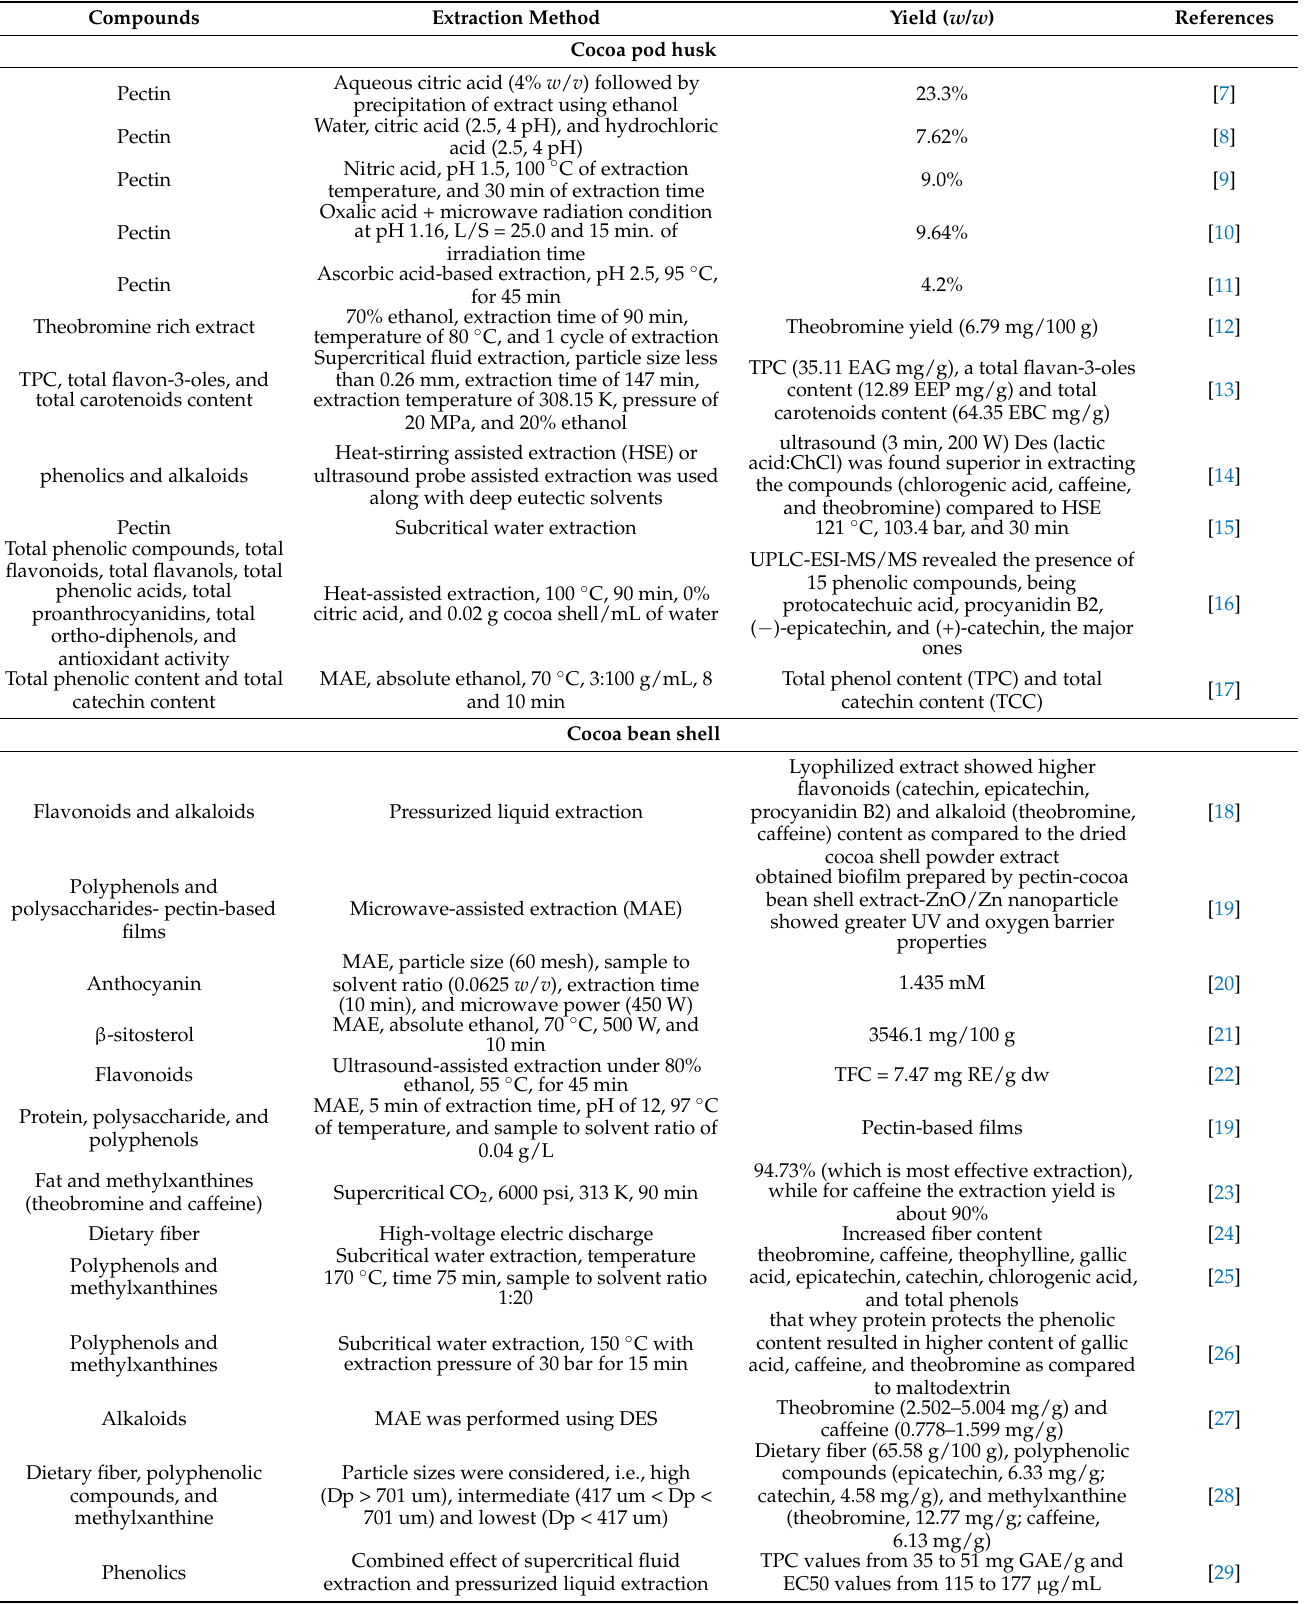
Table 1. Extraction methods used for obtaining bioactive compounds from cocoa pod husk or cocoa shell in the last